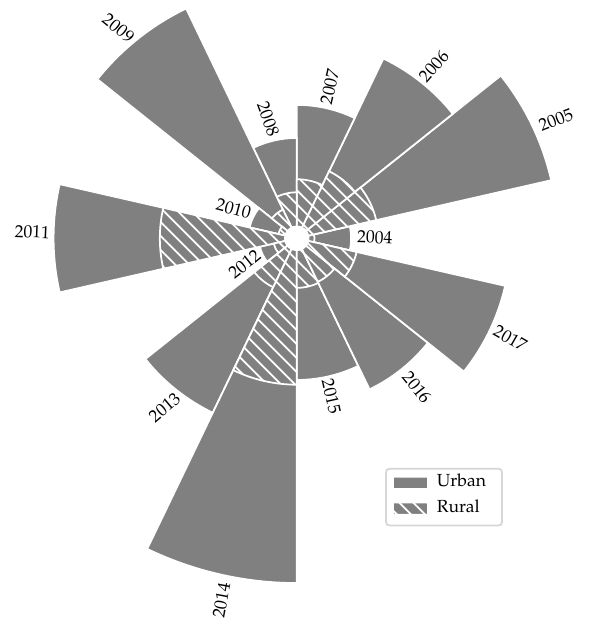
Figure 5. Portion of the number of cases per-capita in urban and rural areas per year.